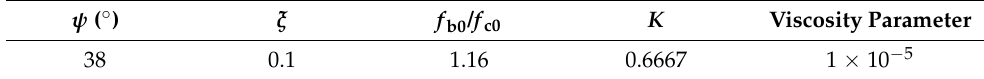
Table 3. Plastic parameters of clay